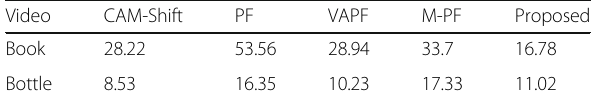
Table 8 Resulting of averaged height error